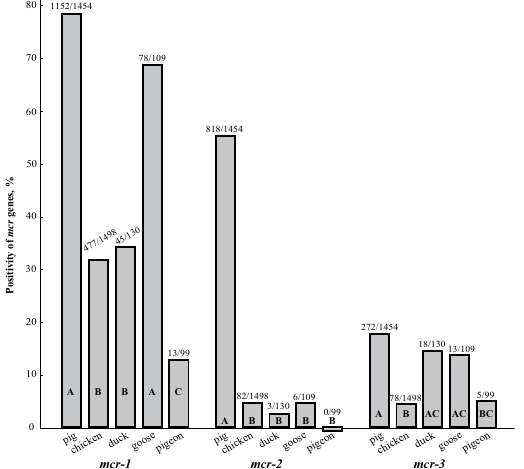
Figure 2. Prevalences of mcr-1 , mcr-2 and mcr-3 in swabs from pigs and poultry. The prevalences of mcr-1 in chickens (31.8%) and ducks (34.6%) were significantly lower than those in pigs (79.2%) and geese (71.7%), but significantly higher than in pigeons (13.1%). The mcr-2 prevalence in pigs was 56.3%, significantly higher than in chickens (5.5%), ducks (2.3%), geese (5.5%) and pigeons (0%). The prevalences of the mcr-3 in pigs (18.7%), ducks (13.8%) and geese (11.9%) were significantly higher than in chickens (5.2%) and pigeons (5.1%). Different letters within bars indicate statistical significance across species, as determined by multiple Pearson Chi-Square test via comparing proportions between two species with Bonferroni adjusted p-values.